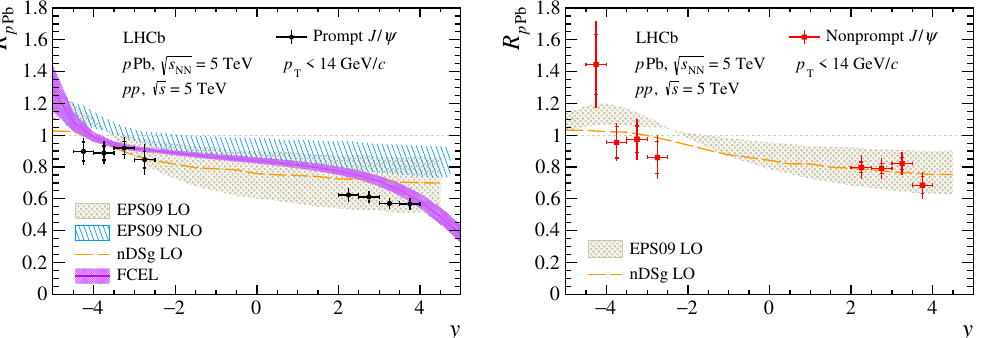
Figure 10 . Nuclear modification factor R p Pb as a function of y for (left) prompt and (right) nonprompt J/ψ mesons, together with the theoretical predictions from (yellow dashed line and brown band) ref. [61], (blue band) ref. [62], and (violet solid line with band) refs. [63, 64]. In the data points the full error bars represent the statistical and systematic uncertainties added in quadrature, while the smaller ones represent the statistical